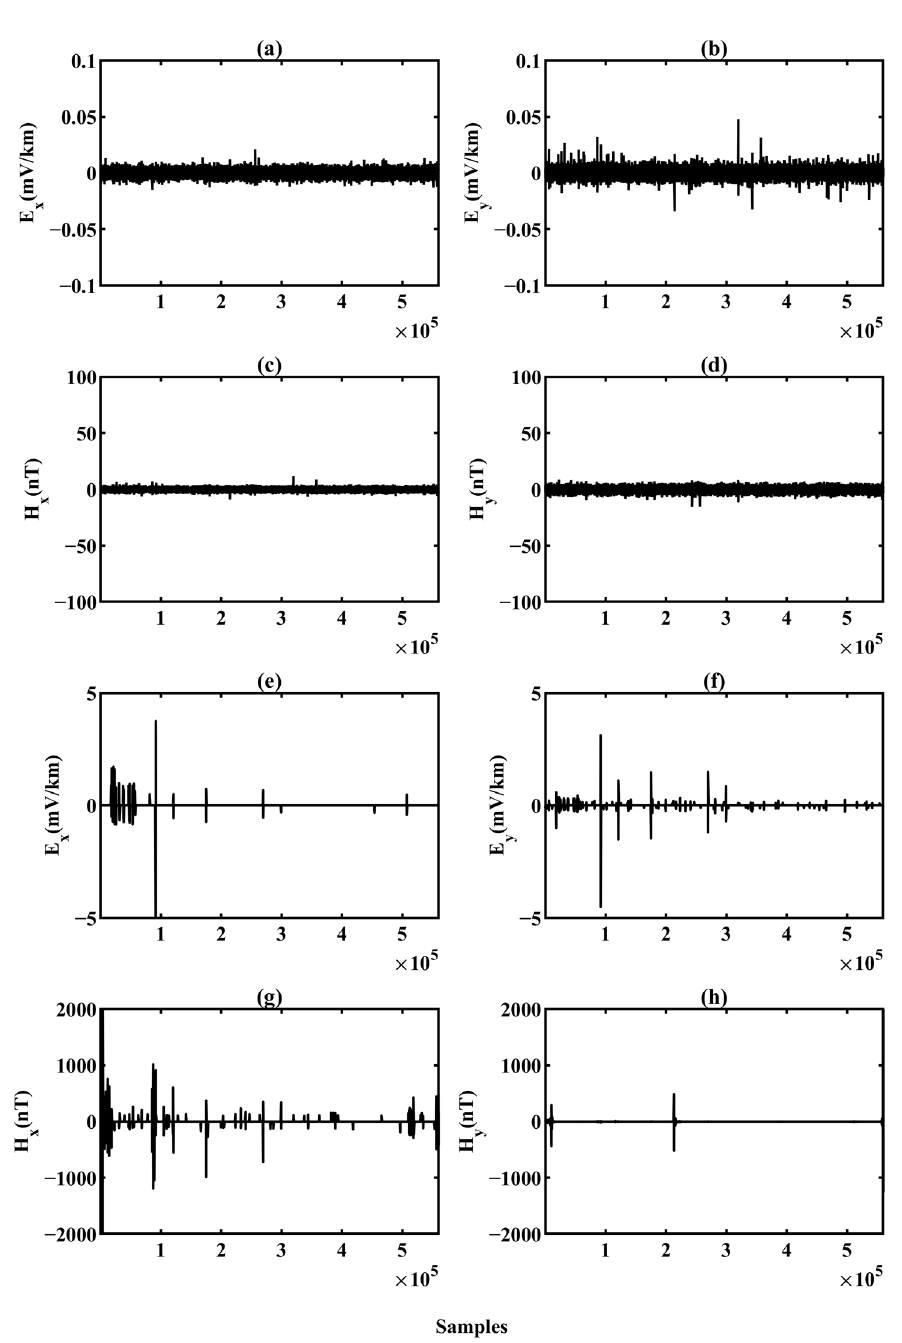
Figure 12. The denoising results of the 12th test dataset. ( a – d ) are the denoising results for e x , e y , h x , and h y , respectively. ( e – h ) are the extracted noise for e x , e y , h x , and h y , respectively.